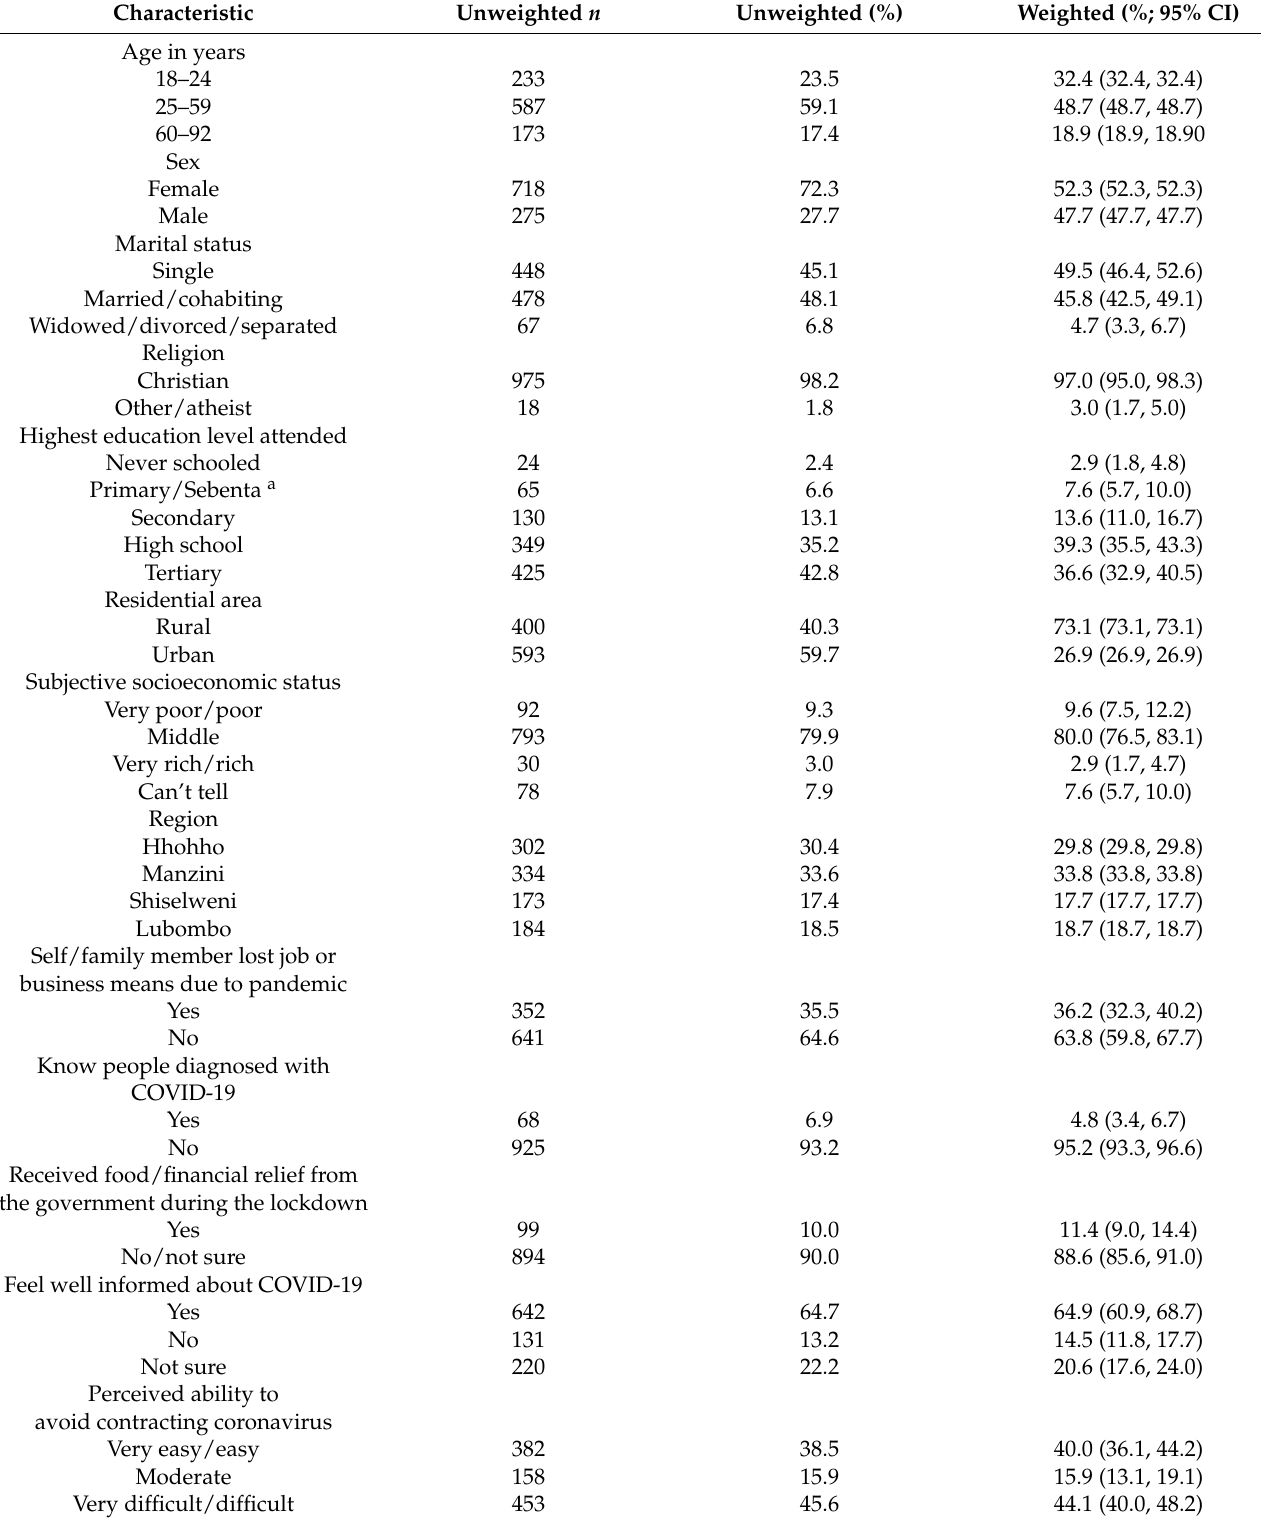
Table 1. Participants’ background characteristics (unweighted N = 993; weighted N = 700,051).